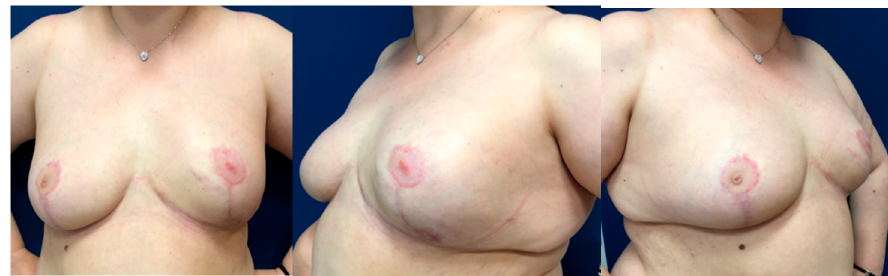
Figure 7. Appearance at 14 months after surgery.